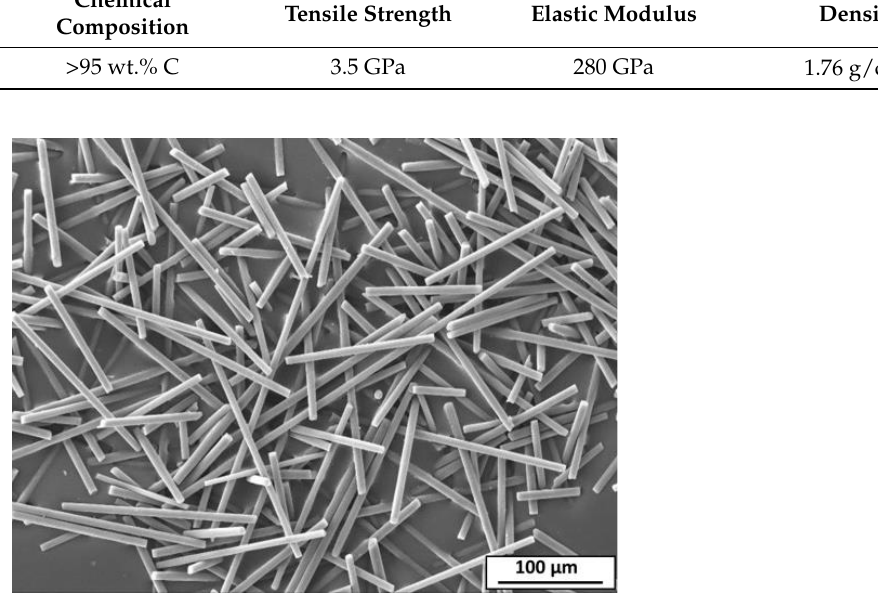
Table 2. The chemical composition and mechanical properties of short carbon fibers. Table 1. The chemical composition of the AZ91 Mg alloy.